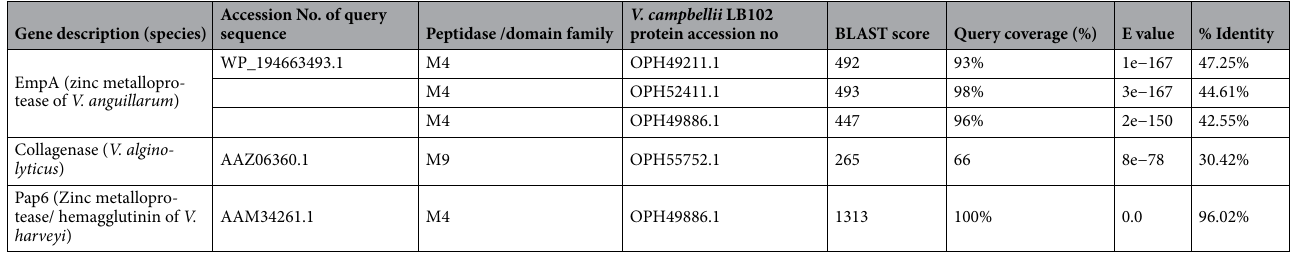
Table 3. Extracellular zinc metalloprotease in Vibrio campbellii